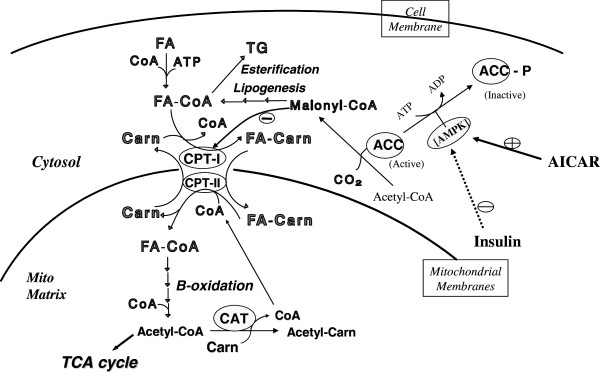
Key roles of CPT I and ACC in fatty acid metabolism. FA - Fatty acid, TG - Triglycerides, Carn – Carnitine, CPT - carnitine palmitoyltransferase, ACC - acetyl-CoA carboxylase, and AICAR - 5-aminoimidazole-4-carboxamide ribonucleoside.